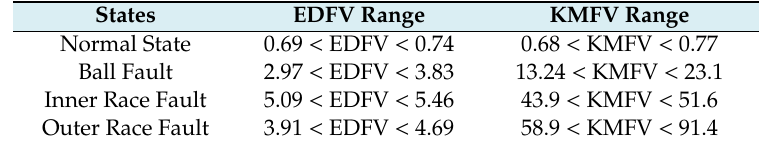
Figure 11. Results of Method 1: EDFV. Table 4. The ranges of feature